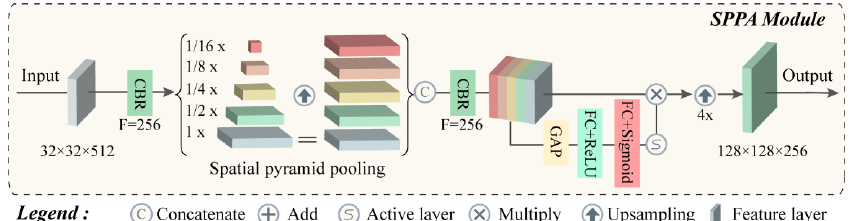
Figure 3. Illustration of the spatial pyramid pooling attention module. CBR = convolutional layer (Conv) + batch normalization layer (BN) + rectified linear unit (ReLU), GAP = global average pooling, F = filters.